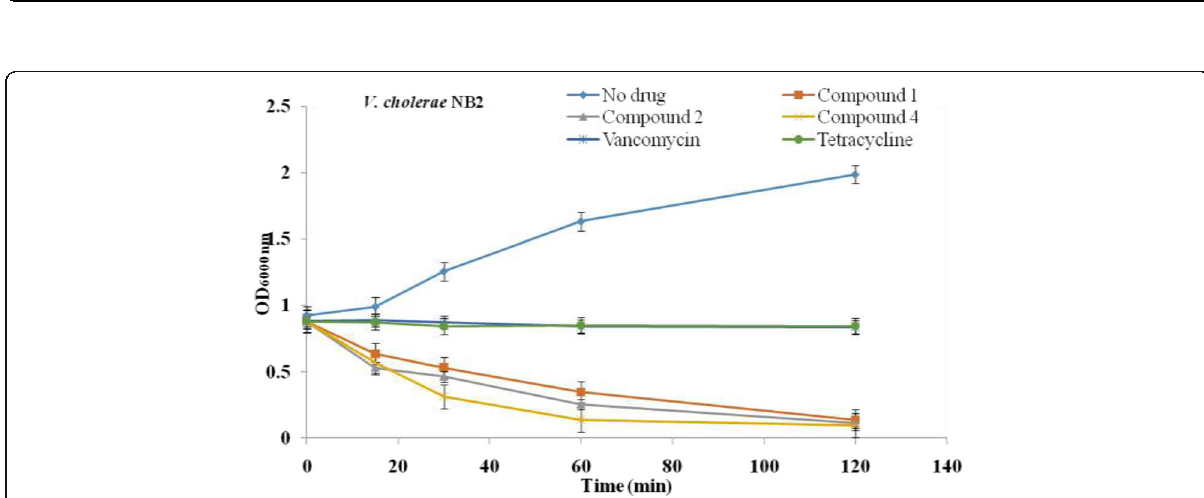
Fig. 3 Bacteriolytic effect of compounds 1 , 2 and 4 against V. cholerae NB2. Results represent the mean ± standard deviation of the triplicate OD at each incubation time